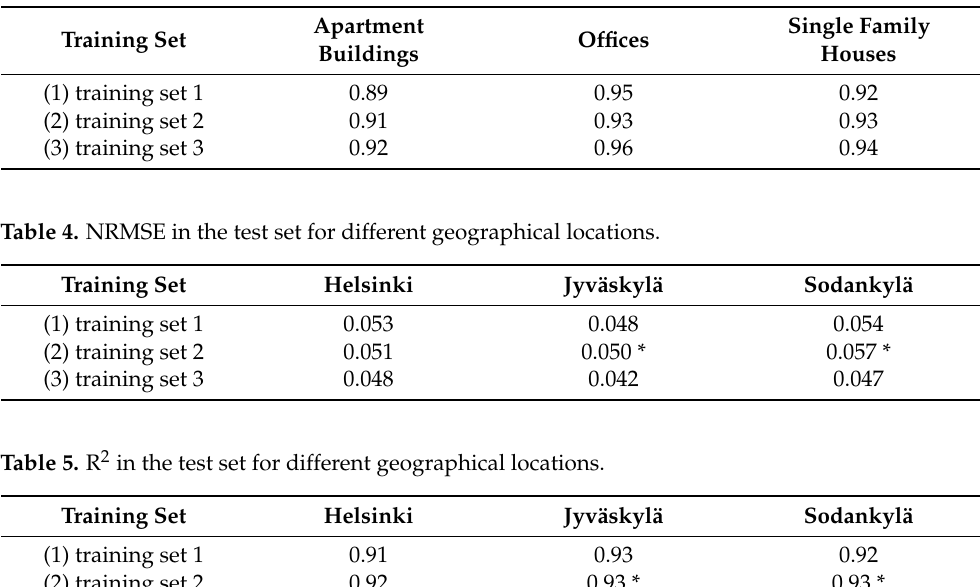
Figure 2. One year examples of measured (red) and forecast (blue) heating load for different building types (apartment, office, single family home).